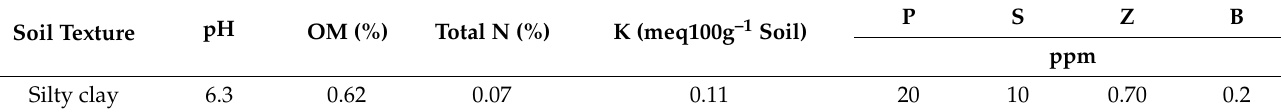
Table 1. Initial soil features of the research fields before the experiment.